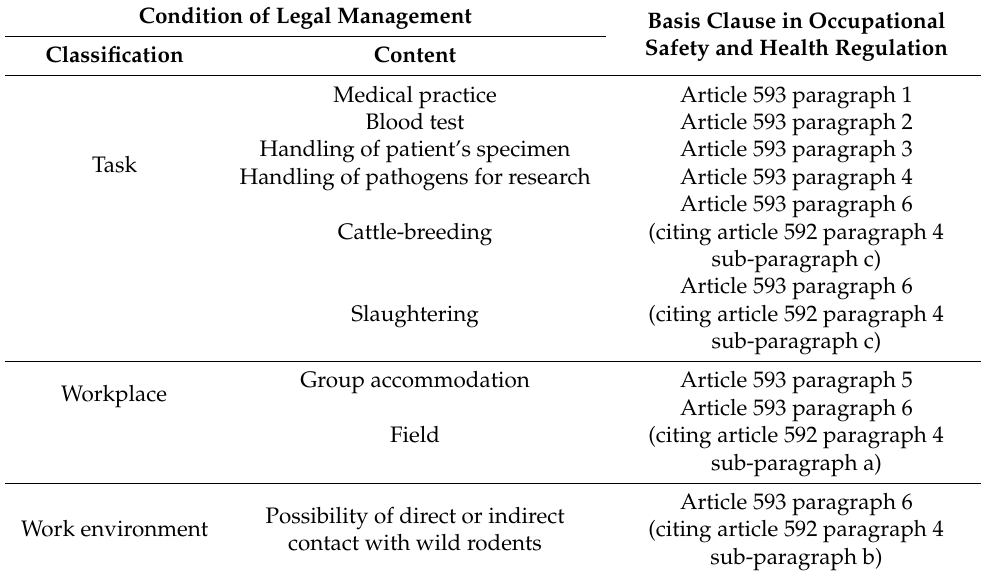
Table 1. Biological hazard control system under the Occupational Safety and Health Act of